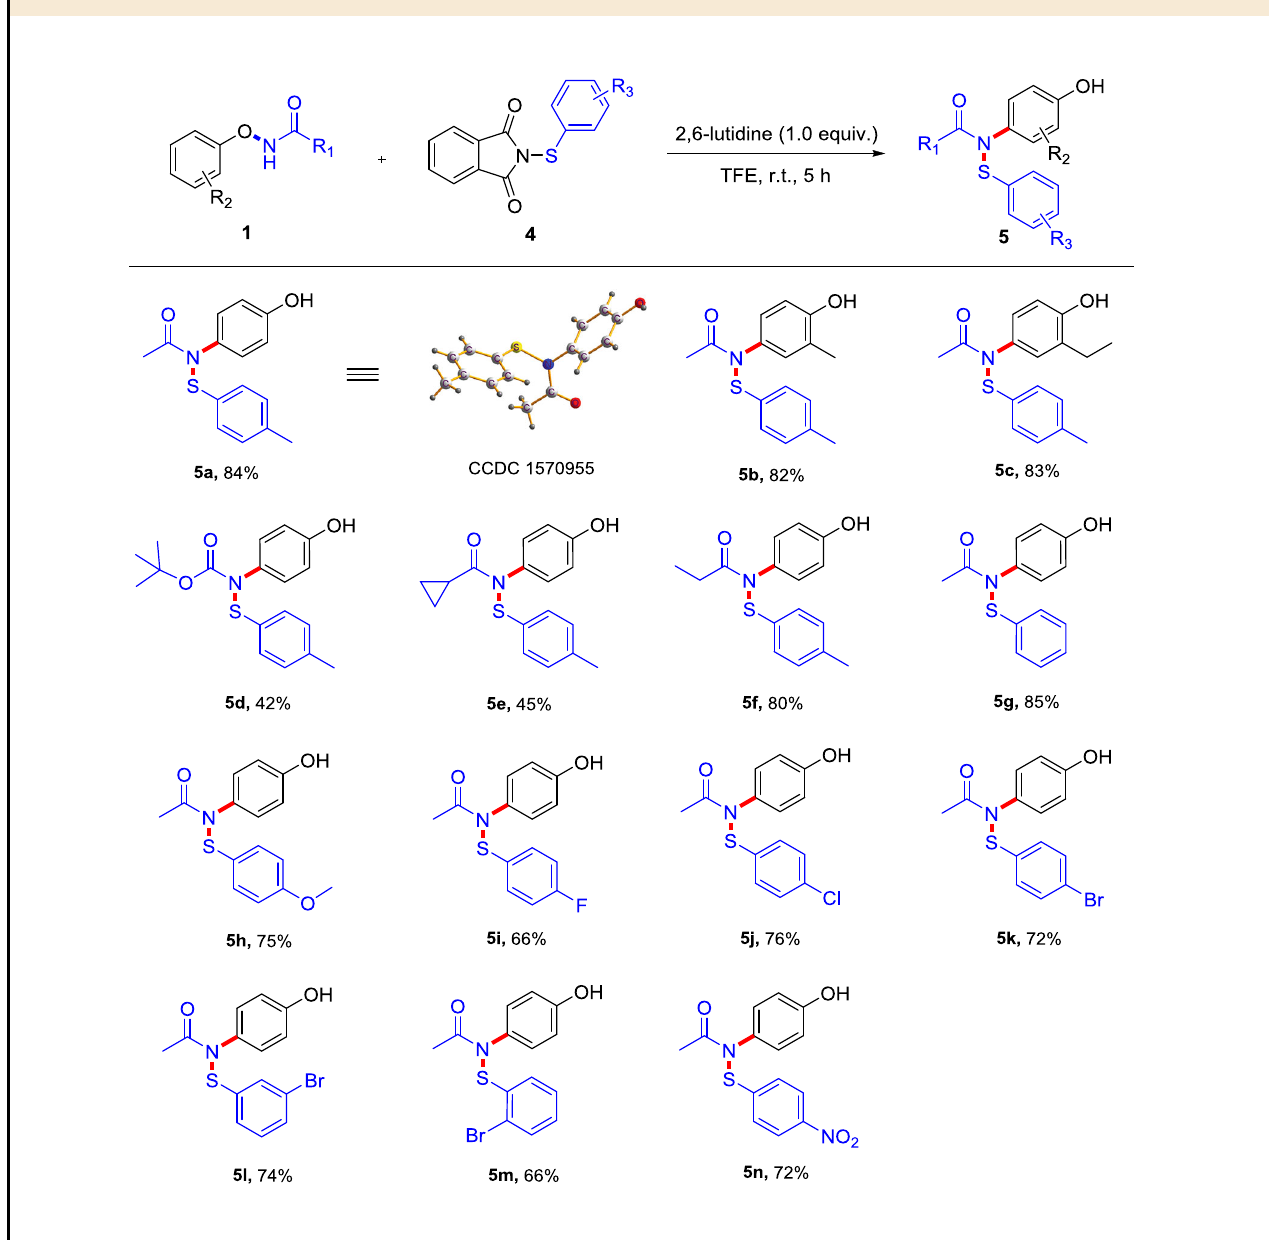
Table 3 Substrate scope of S-mediated reaction